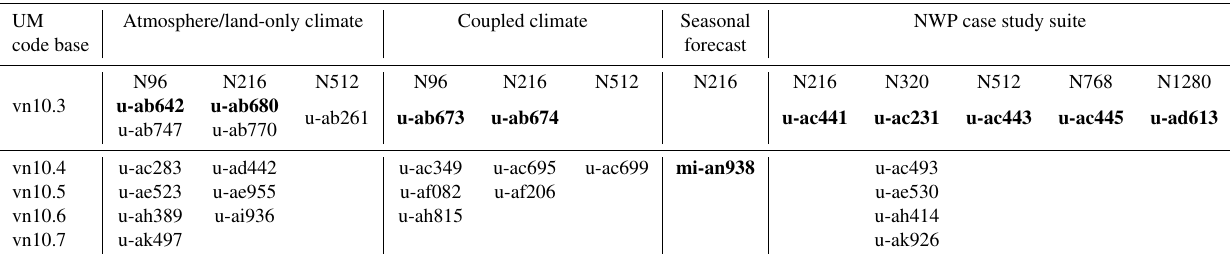
Figure 25. Annual mean top-of-atmosphere reflected SW radiation (Wm − 2 ) in a pair of 20-year N216 atmosphere/land-only climate sim- ulations using GA7.0 and GA7.1. The panels show GA7.1 (a) , the difference from GA7.0 (b) and the bias compared to CERES-EBAF observations in GA7.0 (c) and GA7.1 (d) . Table 9. Identifiers for a set of GA7.0/GL7.0 reference simulations across a number of UM code versions and systems and applications. These suites are held on the Met Office Science Repository Service, which also holds the UM and JULES code. Identifiers marked in bold denote those used in the original assessment of the GA7.0 configuration. Note that in addition to these coupled UM–JULES simulations, a stand-alone reference JULES-GL7 simulation is available in suite